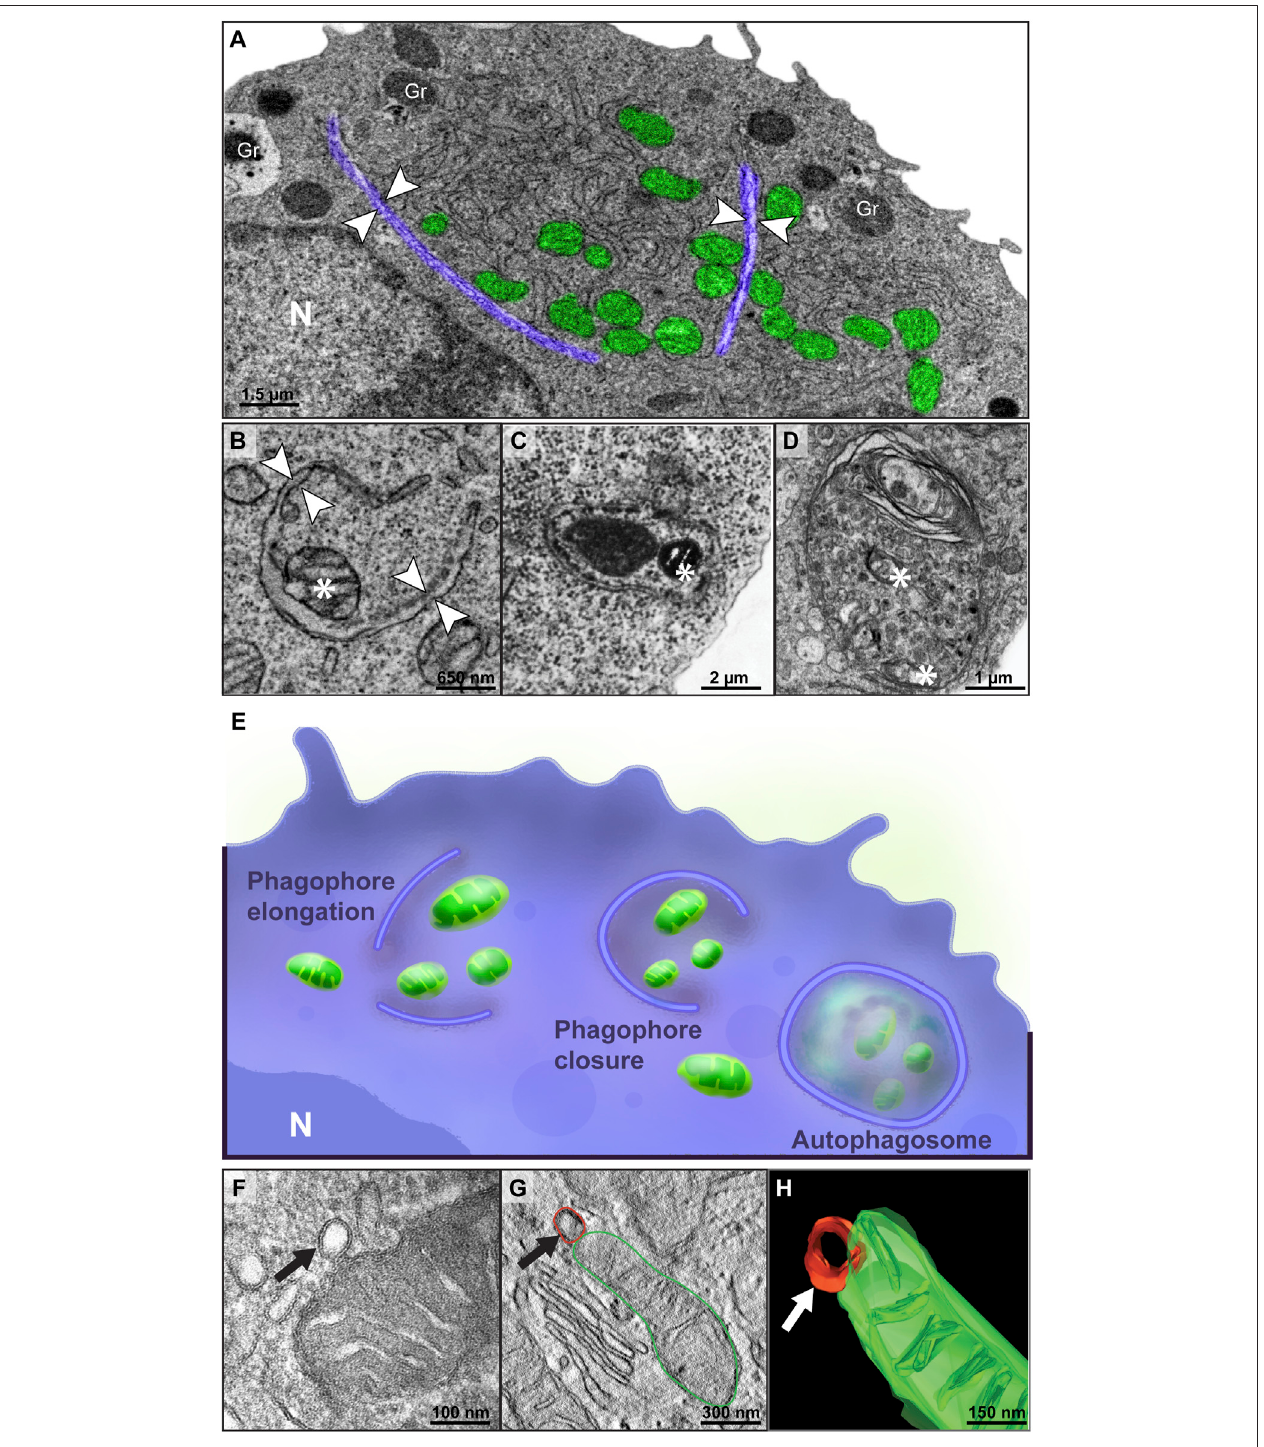
FIGURE3| Mitophagyisaconsistentprocesswithinimmatureeosinophils. (A – D) Mitophagyeventsrepresentedbytheformationofphagophore-likemembranes (arrowheads) in different stages of extension enclosing single or groups of mitochondria and double-membrane vacuoles containing luminal mitochondria (*) (C,D) were observedbyTEM.In (A) ,notethatthephagophoremembranes(coloredinpurple)aresegregatingaportionofthecytoplasmcontainingmitochondriaandERcisternae. In (E) , an illustration shows the multi-step process of mitophagy. (F – H) Electron tomographic analyses captured a mitochondrial-derived vesicle (arrow) being formed from the outer membrane. Cells were prepared for conventional TEM and electron tomography as before (Melo et al., 2005). Gr, secretory granules; N, nucleus.